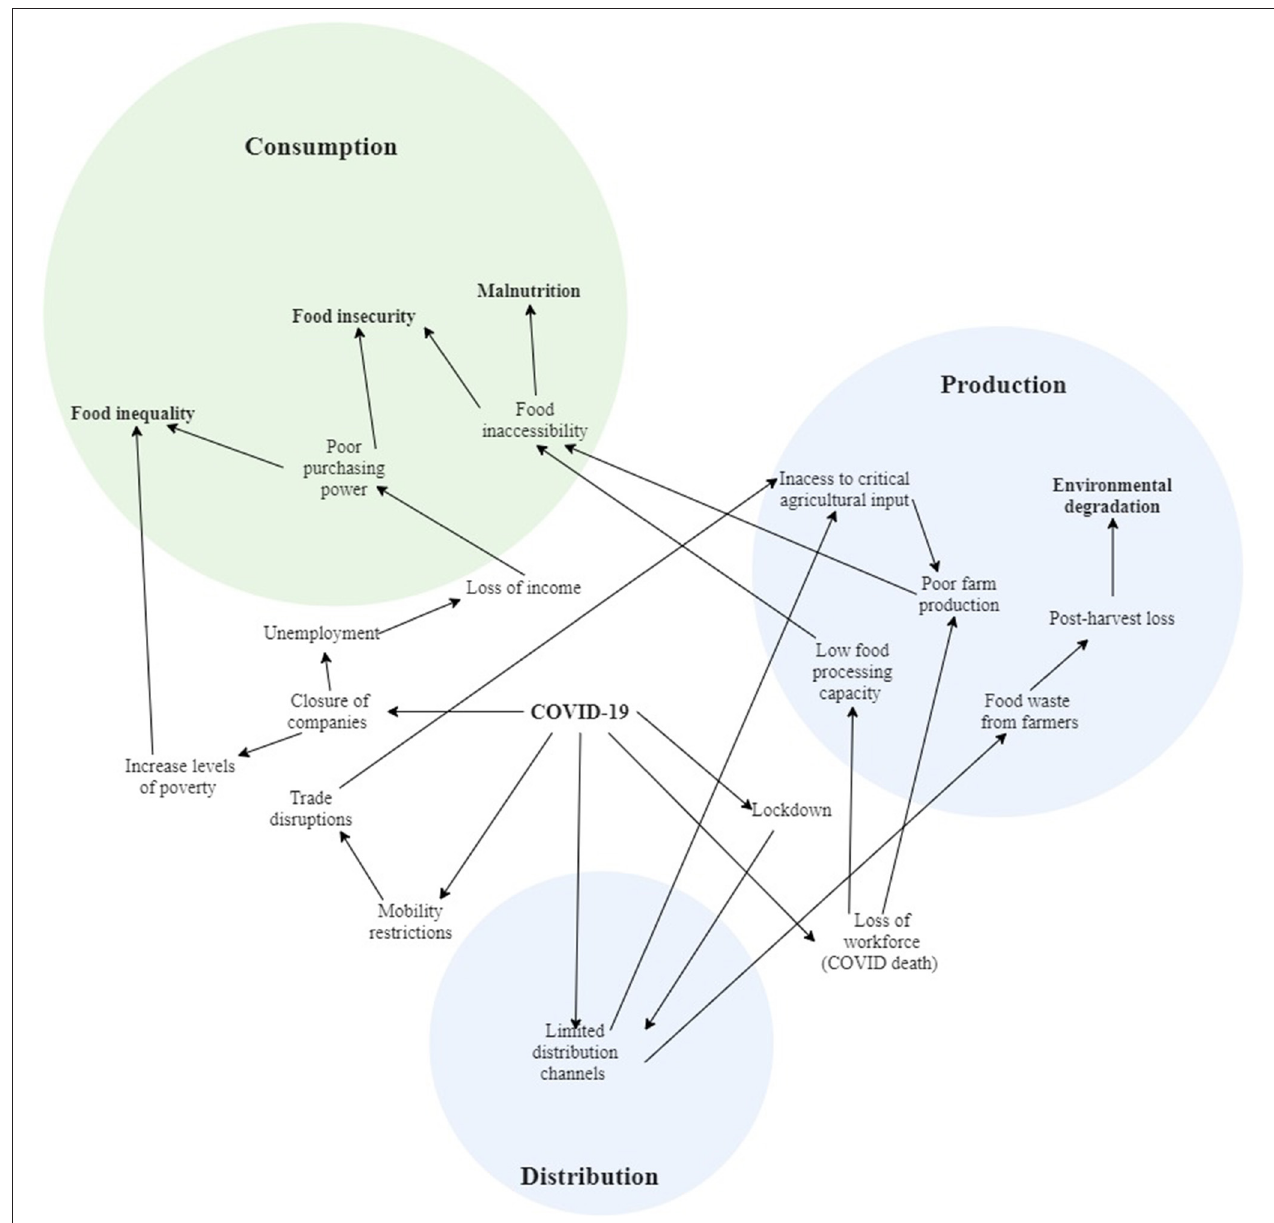
FIGURE 2 | Disruptions caused by COVID-19 which has exacerbated food insecurity and